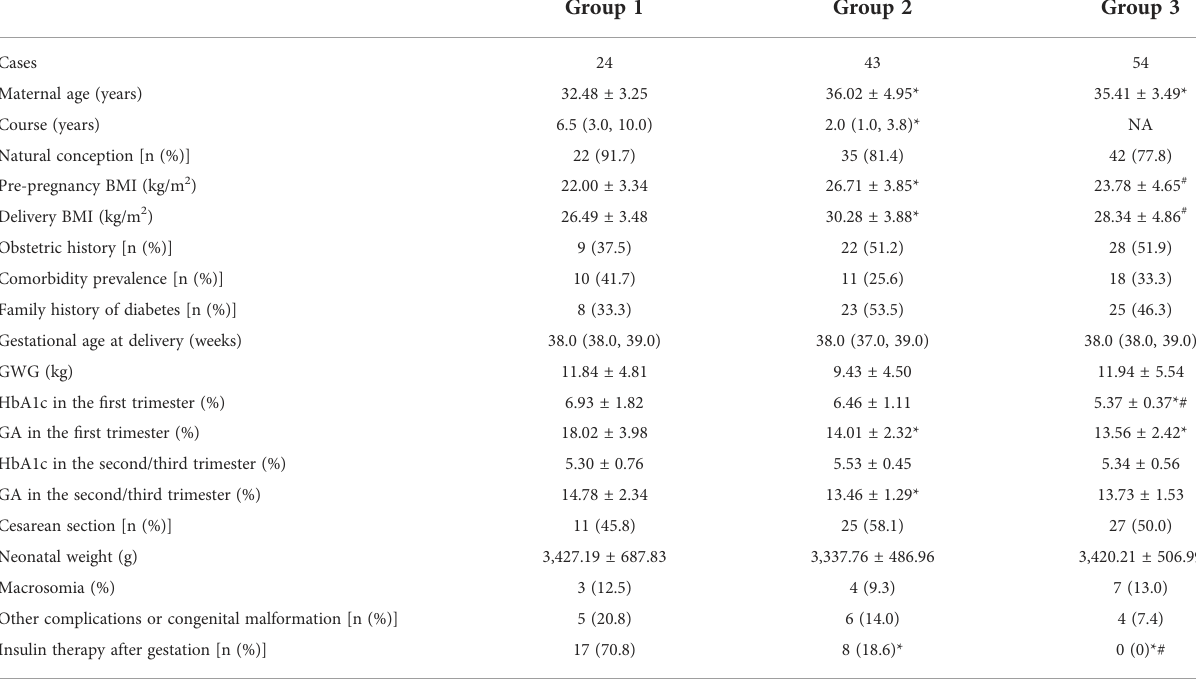
Group 1 Group 2